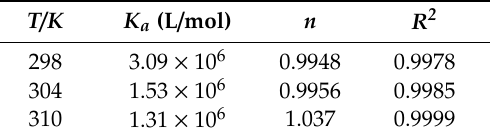
Binding parameters obtained from the interaction of GA with Pv by a double-logarithmic